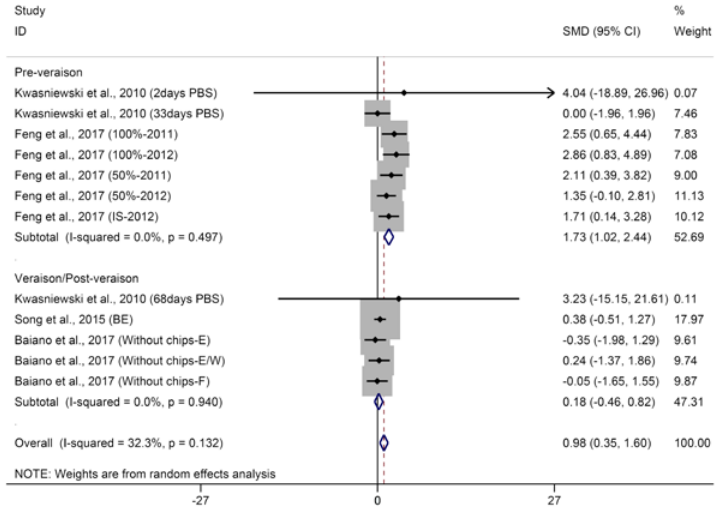
Figure 1. Meta-analysis for the effects of basal defoliation on β -damascenone in wine, of which trials were categorized based on the timing of basal defoliation (pre-veraison and veraison/post-veraison).